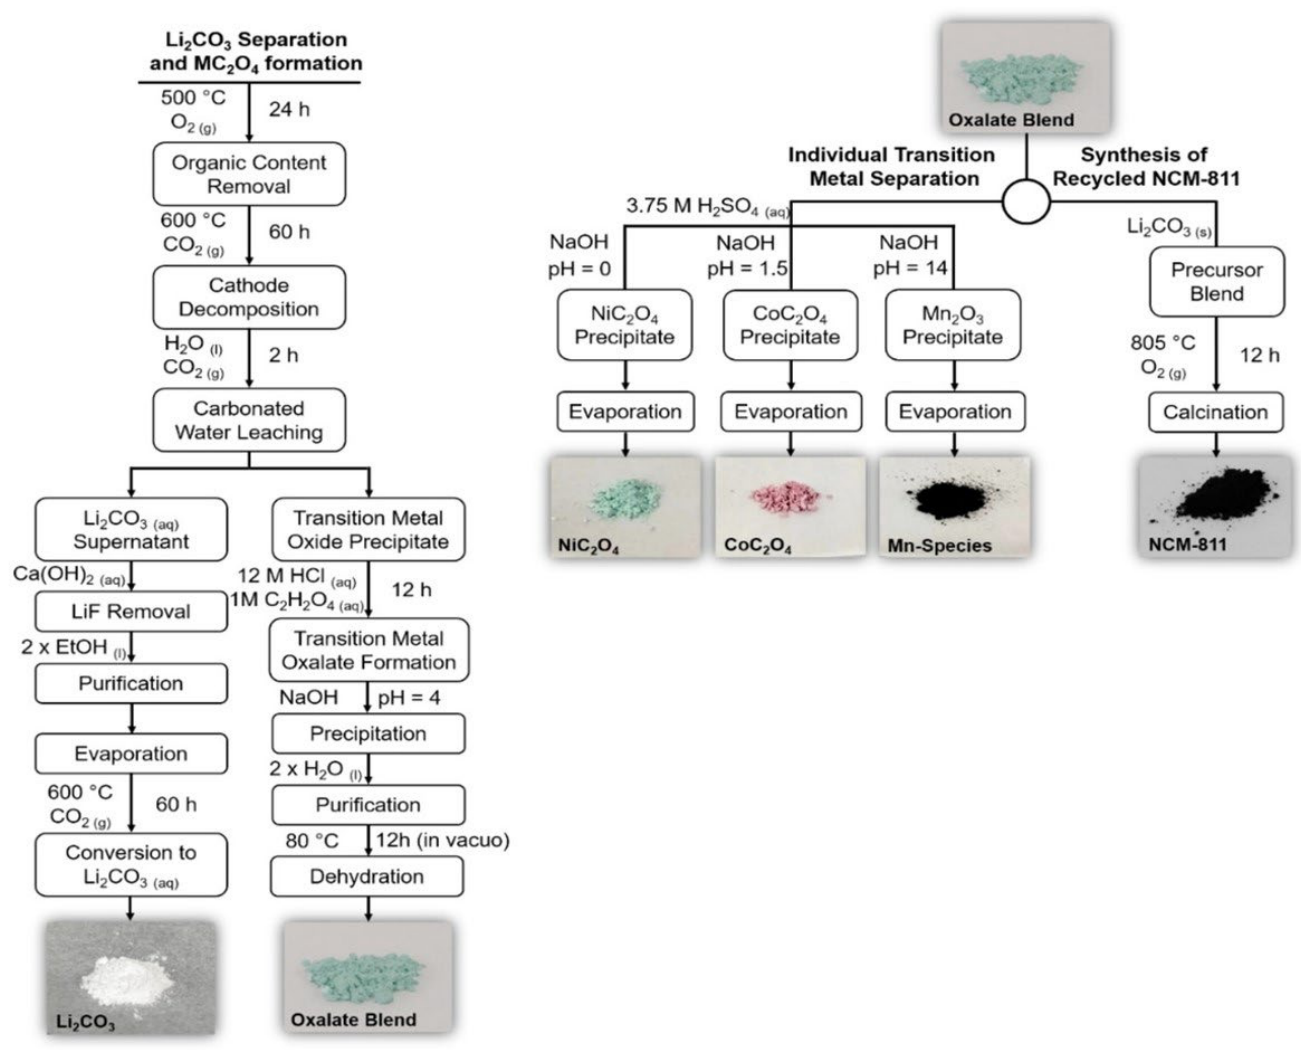
Figure 10. Schematic illustration of the employed recycling technique for NCM-811. During this process, the active material can be regenerated using the Li 2 CO 3, and the oxalate blend or each component of the active material can be individually separated [73]. Ref. [73] is an open access article published by Wiley-VCH GmbH under the terms of the Creative Commons Attribution License, which permits use, distribution and reproduction in any medium, provided the original work is properly cited.